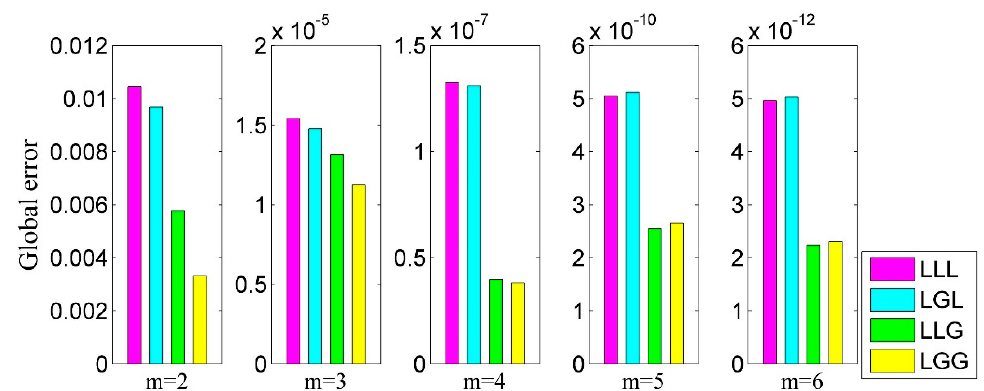
Figure 3. Nonlinear spring pendulum: Global error of Hamiltonian of LLL, LGL, LLG and LGG with m = 2, 3, ··· , 6 and time step η = 0.1.